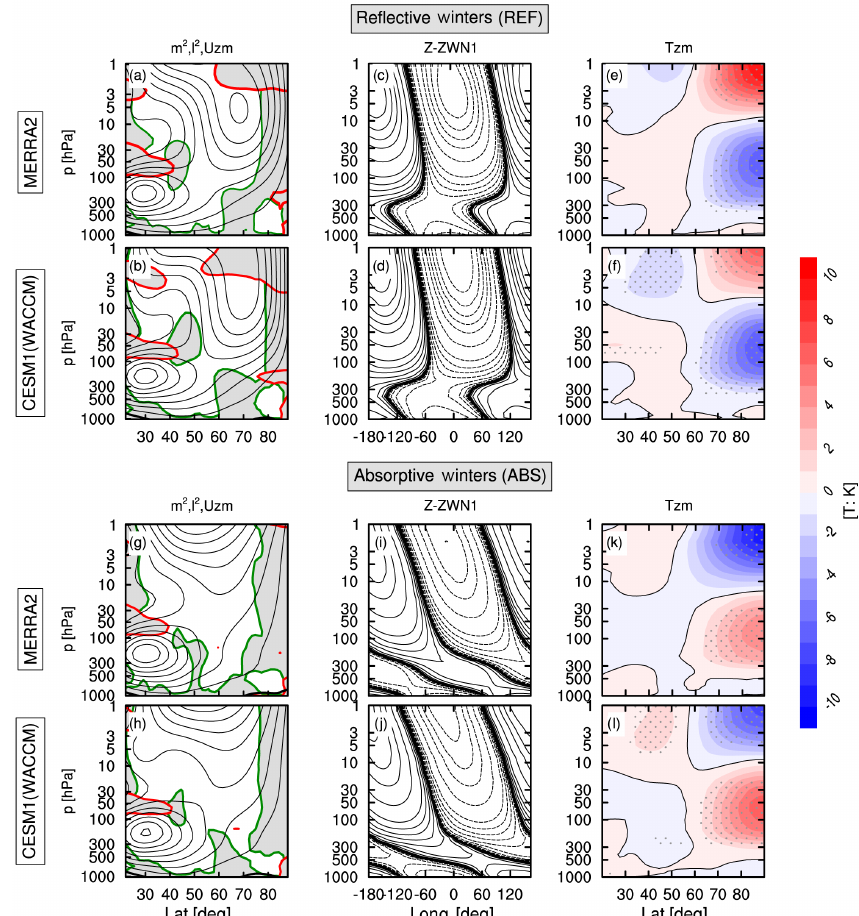
Figure 10. Composites of the zonal-mean zonal wind, wave-1 geopotential height, and temperature mean differences for reflective (REF) and absorptive (ABS) winters in JFM from MERRA2 and CESM1(WACCM). (a, b, g, h) The zonal-mean zonal wind (black contour lines) superimposed with vertical and meridional wave numbers (red and green contour lines). The gray shading indicates regions of wave evanescence and the red (green) contour line indicates the vertical reflecting surface m 2 = 0 (meridional wave guide l 2 = 0). Contour interval for the zonal mean wind is 5ms − 1 . (c, d, i, j) The wave-1 geopotential heights averaged between 60 and 70 ◦ N; contour interval is logarithmic powers of 2: ± [0.5, 1, 2, 4, 8, 16, 32, 64, 128, 256, ...]m. (e, f, k, l) The zonal mean temperature differences (REF or ABS minus the 1980– 2013 climatological mean). Blue (red) contours indicate cooler (warmer) regions compared to the climatology. The contour interval is 1K. The stippling indicates differences significant at the 95% confidence